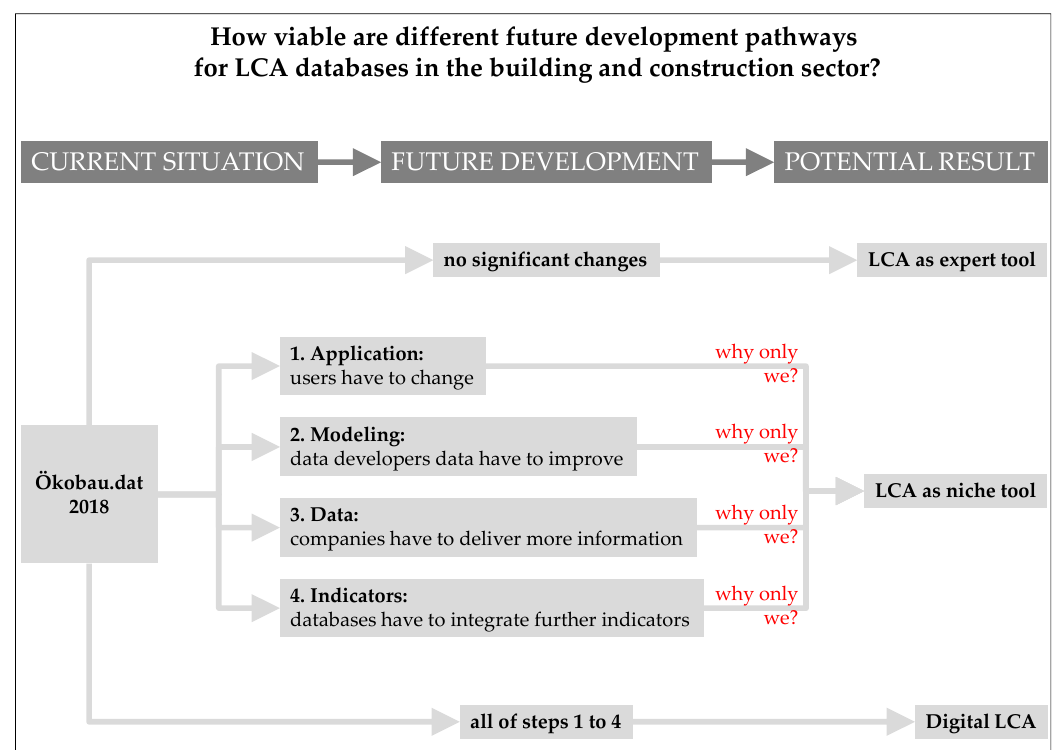
Figure 5. Future options for development of Ökobau.dat and other LCA databases in the building and construction sector.